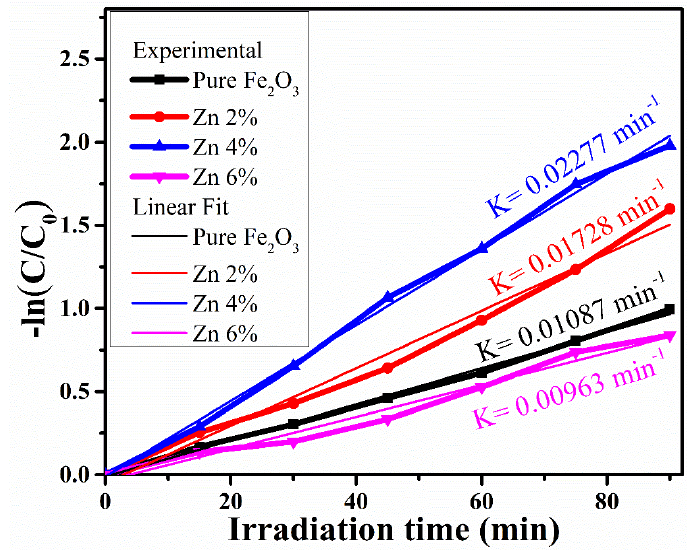
Figure 8. Experimental and linear plot of − ln(C/C 0 ) versus irradiation time for pure Fe 2 O 3 , Zn 2%, Zn 4% and Zn 6% nanoparticles. Table3. CalculatedphotodegradationparametersofpureFe 2 O 3 , Zn2%,